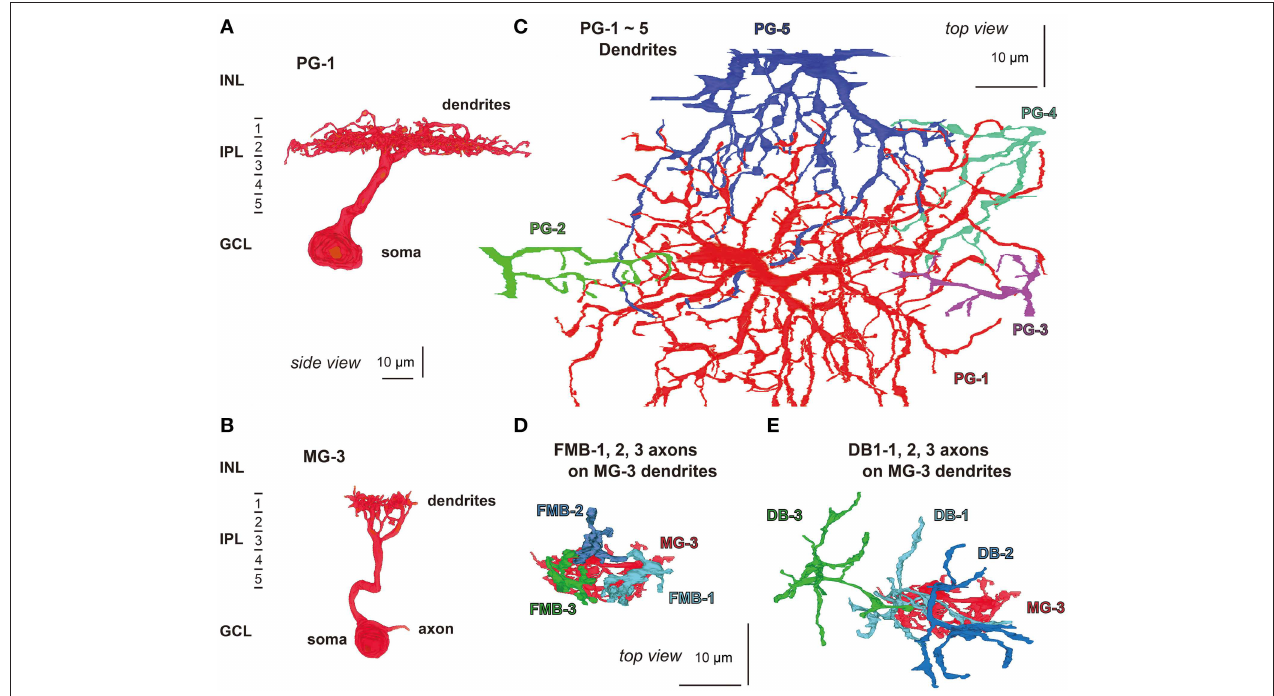
FIGURE 8 | Morphology and stratification of parasol (PG-1) and midget (MG-3) ganglion cells. (A) A parasol ganglion cell (PG-1) and (B) a midget ganglion cell (MG-3) in side view. (C) The dendrites of a parasol ganglion cell (PG-1: red) and four others (PG-2 to -5: green, blue-violet, blue-green, and red-violet, respectively) in top view. (D,E) Cell MG-3 dendrites (red) are innervated by the axon terminals of three FMB cells (FMB-1, -2, and -3: light blue, dark blue, and green, respectively) and three DB1 cells (DB1-1, -2, and -3: in the same colors) in top